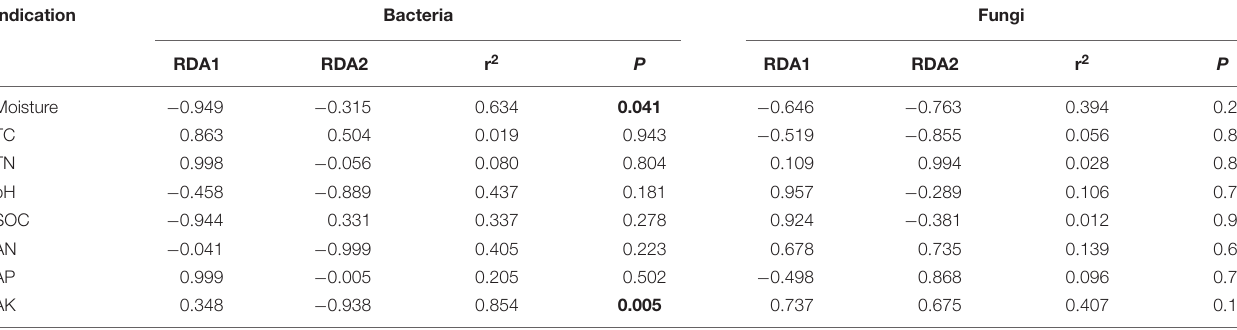
TABLE 3 | Monte Carlo permutation test of soil factors on microbial community structure. Indication Bacteria Fungi